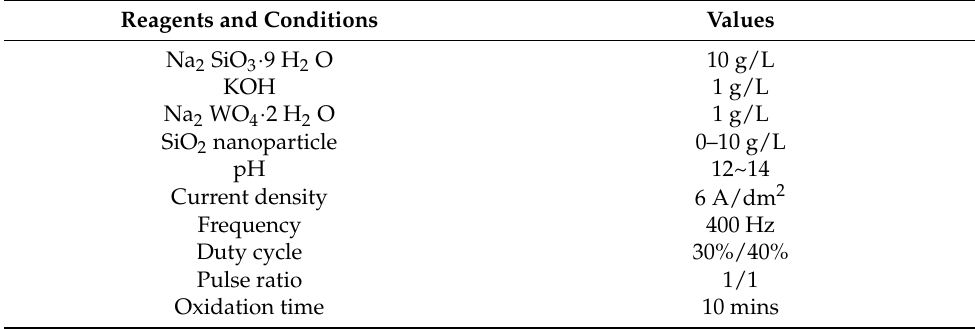
Table 2. Electrolyte Composition and MAO Process